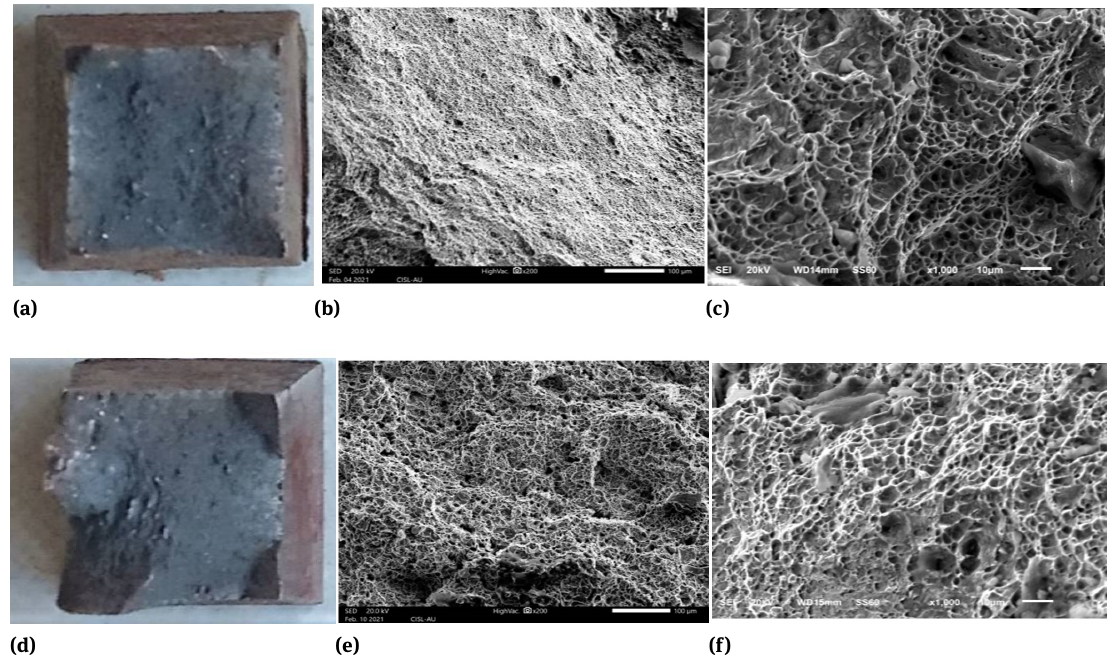
Figure 11: Fracture surfaces of BM and WM tensile